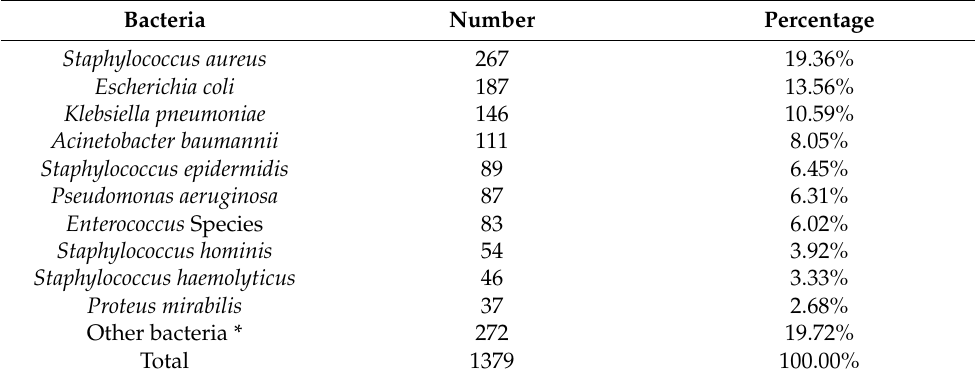
Table 1. The most prevalent bacteria in patients aged less than 48 years.